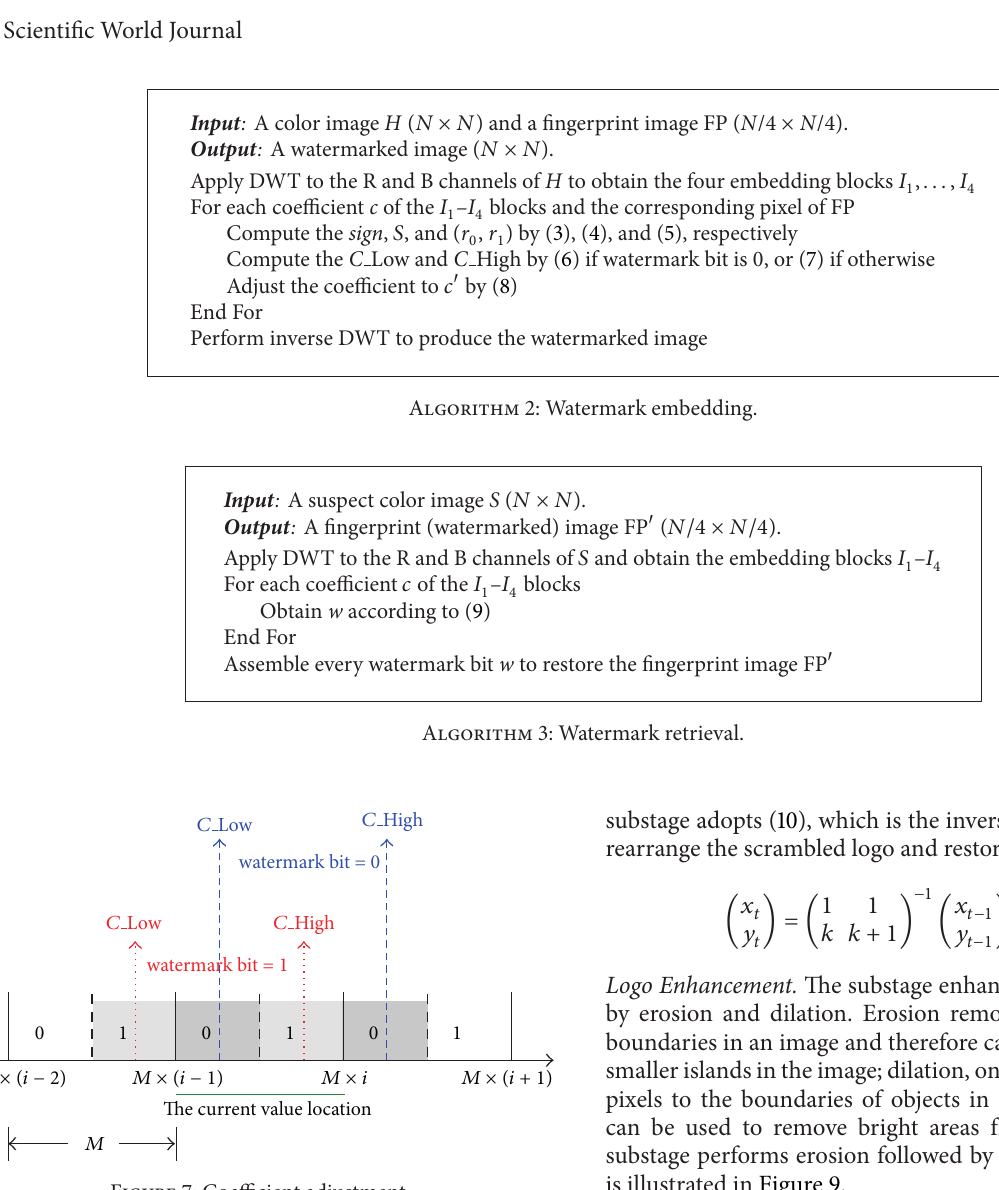
Figure 7: Coefficient